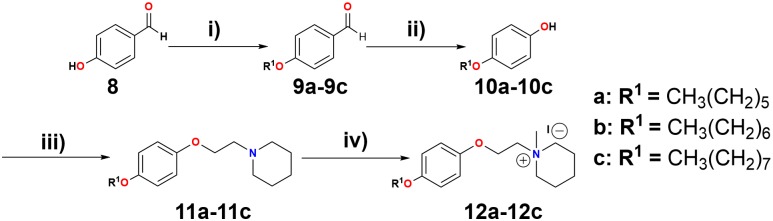
Reagents and conditions: (i) K2CO3, R1-Br, EtOH, reflux, 18 h. (ii) H2O2 (30%), H3BO3, THF, H2SO4. (iii) DIAD, 1,4-dioxane, PPh3, 2-piperidinoethanol, reflux in N2 atmosphere, 48 h. (iv) CH3I, acetone, 16 h.